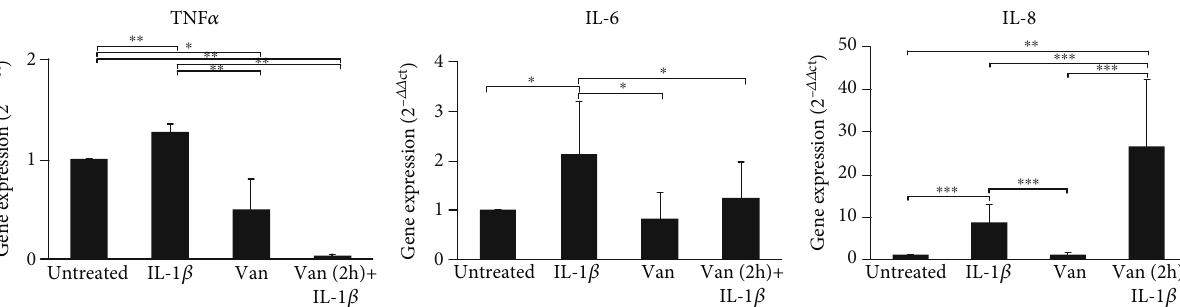
Figure 8: Gene expression of TNF- α , IL-6, and IL-8 in HGF scratched cells. Data are reported as mean and 95% CI, of three independent experiments. ∗ p < 0 : 05 ; ∗∗ p < 0 : 01 ; ∗∗∗ p < 0 : 001 . IL-1 β : IL-1 β -primed cells; Van: Vanillin; Van (2 h)+IL-1 β : Vanillin (2 h pretreatment) plus IL-1 β .